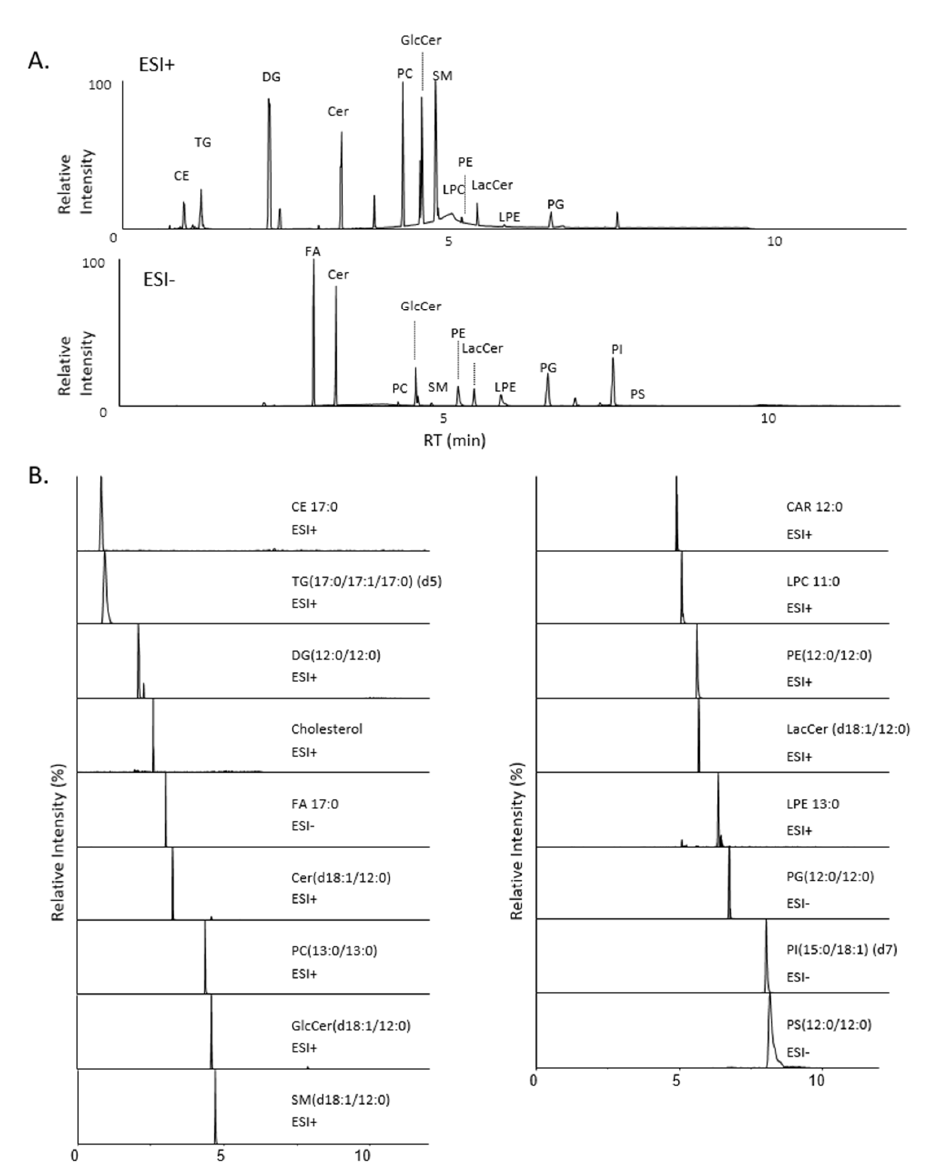
Figure 1. ( A ) Total ion chromatogram (TIC) of internal standards mixture in positive (up) and negative (down) ionization mode. ( B ) Extracted ion chromatogram (EIC) for each internal standards plus free cholesterol and AcylCarnitine: CE 17:0; TG(17:0/17:1/17:0) (d5); DG(12:0/12:0); Cholesterol; Cer(d18:1/12:0); FA 17:0; GlcCer(d18:1/12:0); SM(d18:1/12:0); CAR 12:0; LPC 11:0; PE(12:0/12:0); LacCer(d18:1/12:0); LPE 13:0; PG(12:0/12:0); PI(15:0/18:1)(d7); PS(12:0/12:0) detected either in the positive (ESI+) or in the negative (ESI-) ionization mo